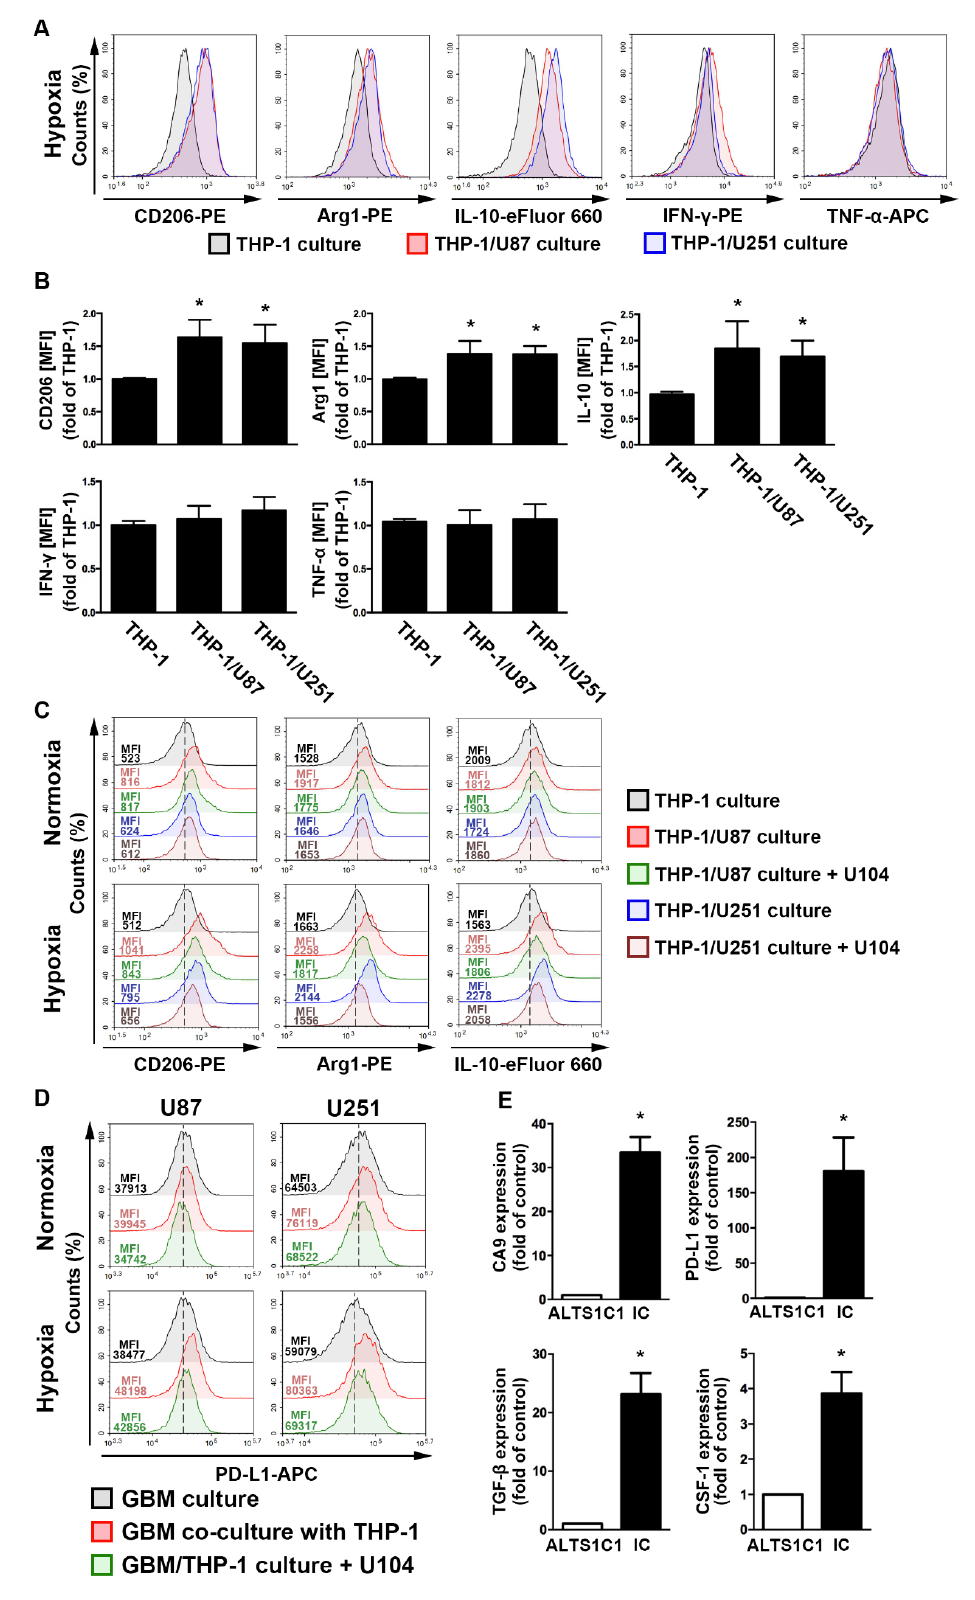
Figure 4. The polarizations of monocyte and GBM progression in a co-cultured model under hypoxic conditions. ( A ) THP-1 monocytes were co-cultured with U87-green fluorescent protein (GFP) or